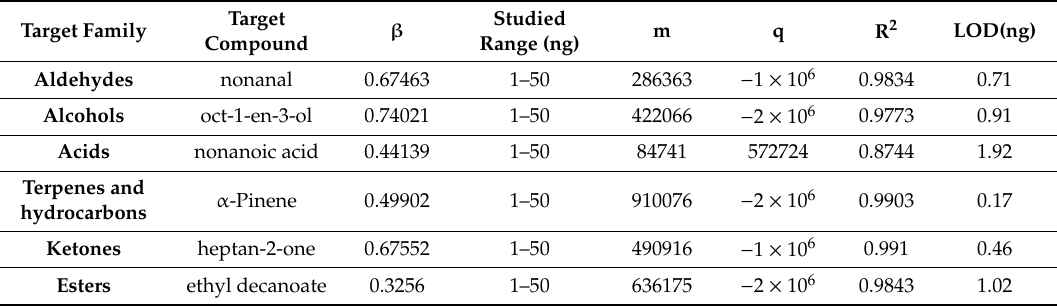
Table 1. Data obtained by the development of the multiple headspace-SPME (MHS-SPME) GC-MS method and by the external calibration curves. β factors were obtained by the logarithmic linear regression plot of the chromatographic areas recorded during the multiple extractions (shown in Figure 1a). The slope (m), the intercept (q) and the correlation coe ffi cient (R 2 ) are referred to the external calibration curves obtained by the injection of four known concentration of standards (shown in Figure